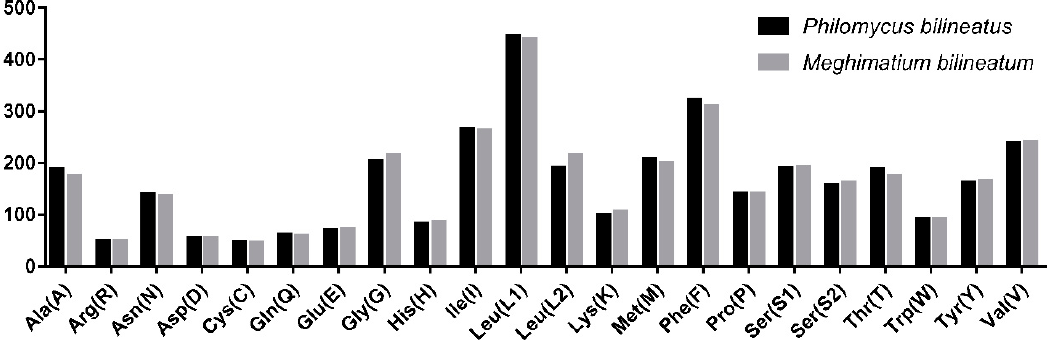
Figure 4. Codon distribution in the P. bilineatus and M. bilineatum mitogenome. Numbers to the left refer to the total number of the codon. Codon families are provided on the X-axis.